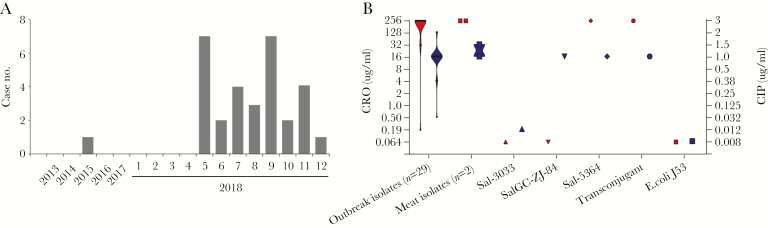

Salmonella Goldcoast infection in Taiwan and antimicrobial resistance of the isolates. (A) Number of the Salmonella Goldcoast cases in Chang Gung Memorial Hospital (CGMH). Between January 2013 and April 2018, only 1 case was reported, whereas between January 2018 and December 2018, 30 cases were identified. (B) Violin plot of the minimum inhibitory concentration (MIC) values of ceftriaxone ([CRO] in red, left y-axis) and ciprofloxacin ([CIP] in blue, right y-axis) for the studied isolates. Isolate Sal-3033 was the only one collected at CGMH before 2018. Isolate SalGC-ZJ-84 was collected from Zhejiang, China instead of Taiwan. The MICs for the donor strain, Sal-5364, the recipient strain, Escherichia coli J53, and the transconjugant obtained in the conjugation experiment demonstrate that the resistance was mediated by a conjugative plasmid.